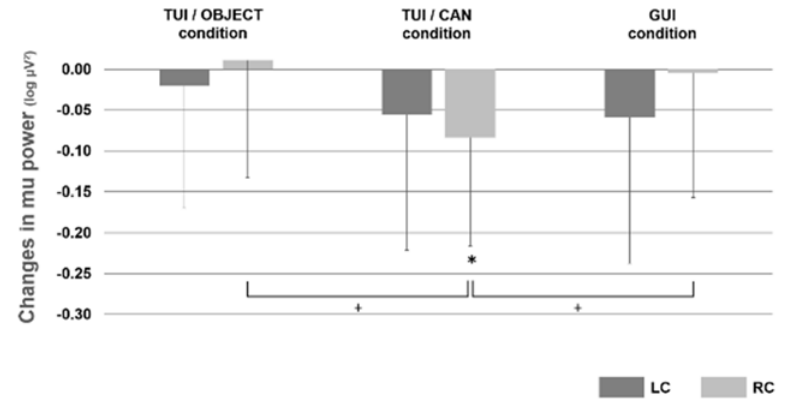
Figure 4. Mu rhythm suppression (LC and RC) in different conditions in Experiment 1. Asterisk (* p < 0.05) means the significant mu rhythm suppression from baseline to observation of each actions. Daggers (+ p < 0.10) mean the tendency in comparison with other conditions at RC.